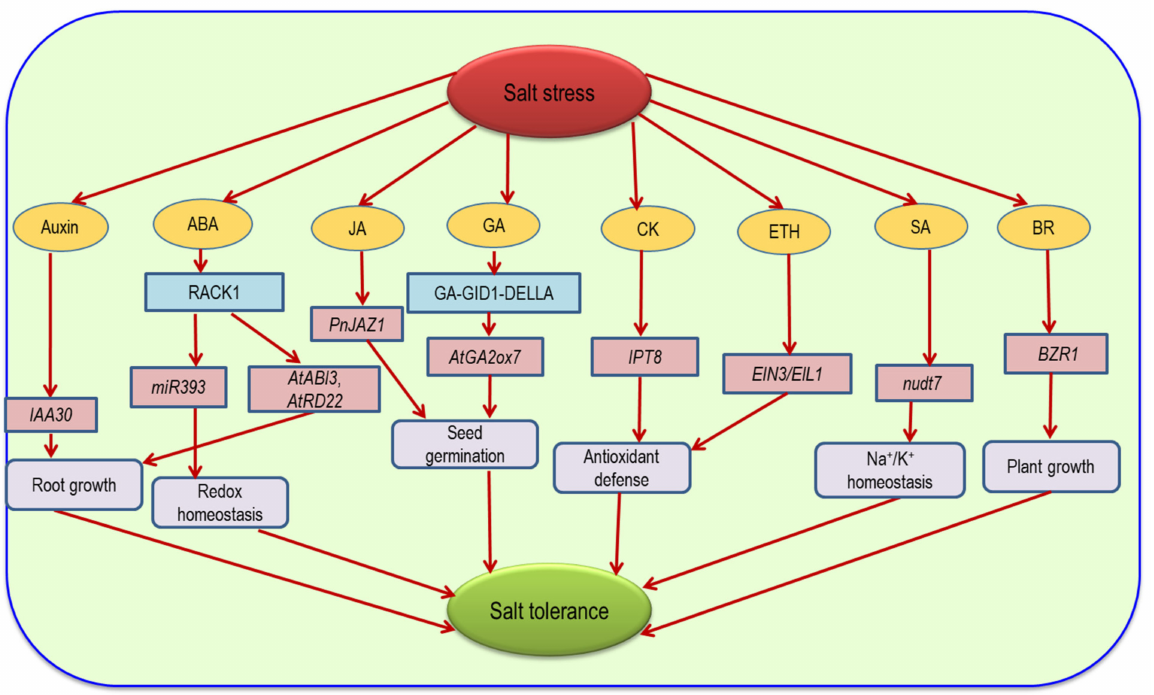
Figure 9. Overview of major plant hormone regulation in Arabidopsis under salt stress where different salinity-mitigating traits of phytohormone-regulated genes help to induce salt tolerance in Arabidopsis . Detailed descriptions are provided in the text. ABA—abscisic acid; JA—jasmonic acid; GA—gibberellic acid; CK—cytokinin; SA—salicylic acid; ETH—ethylene; BR—brassinosteroid; RACK1—receptor for activated C kinase